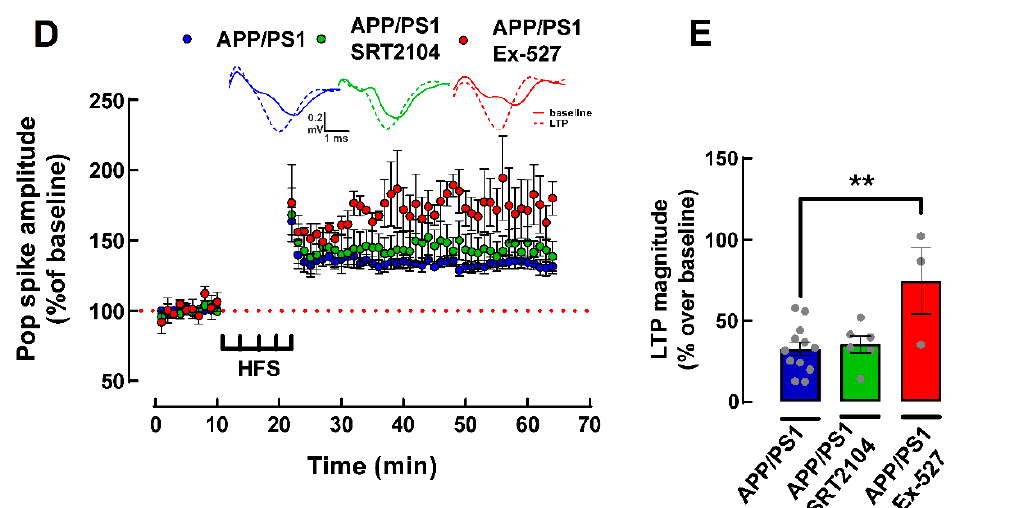
Figure 6. E ff ect of the pharmacological activation and inhibition of SIRT1 on PFC-LTP in 9-month- old WT and APP/PS1 mice. ( A ) Scheme of the experimental protocols illustrating the timing of addition of the different tested drugs in the electrophysiological experiments. ( B ) Time course and ( C ) summary graph showing that activation of SIRT1 with SRT2104 (10 µ M) decreased the magnitude of LTP, while inhibition of SIRT1 with Ex-527 (1 µM) showed a tendency ( p = 0.0896) to decrease the magnitude of LTP in the PFC of WT mice. There was no e ff ect of SRT2104 on top of Ex-527. ( D ) Time course and ( E ) summary graph showing that activation of SIRT1 with SRT2104 did not a ff ect LTP magnitude, while SIRT1 inhibition with Ex-527 signi fi cantly increased the magnitude of LTP in the PFC of APP/PS1 mice. Data are mean ± SEM of 3–12 experiments (number of di ff erent animals tested). ** p < 0.01, one-way ANOVA test.